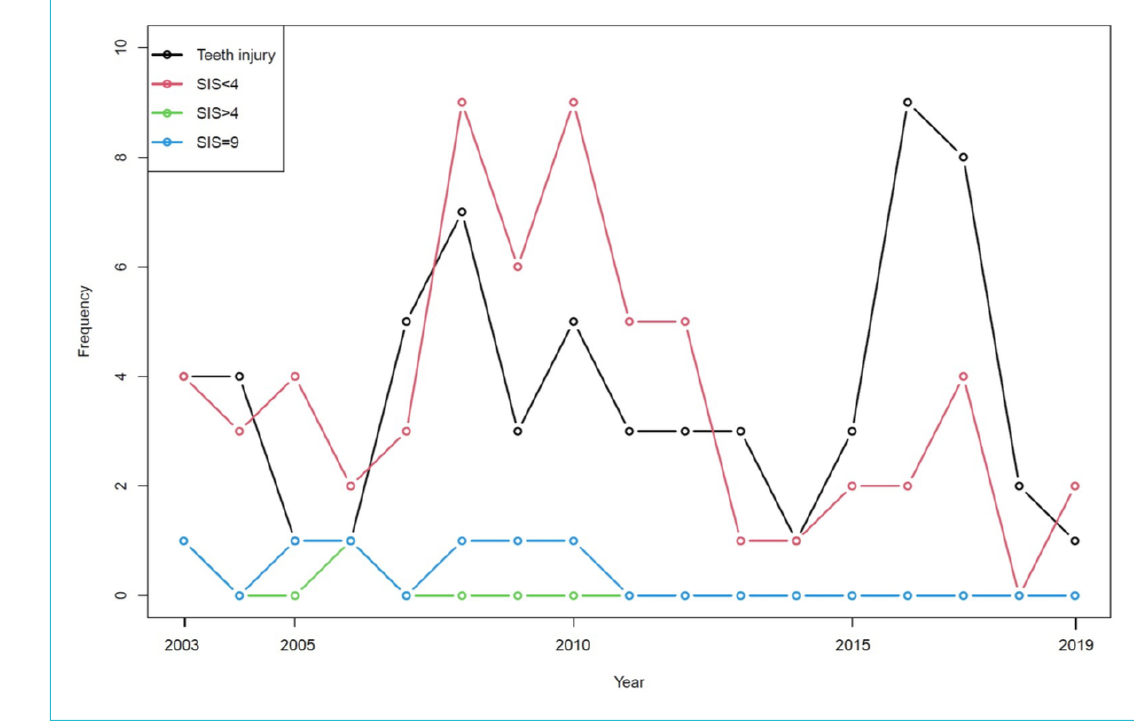
Figure 3: Temporal trends of anaesthesia-related complications SIS <4 (red dotted line), SIS >4 (green dotted line), SIS = 9 (blue dotted line) and tooth injuries (black dotted line) from 2003 to 2019. Number of events by year (n = 133). Each dot represents one